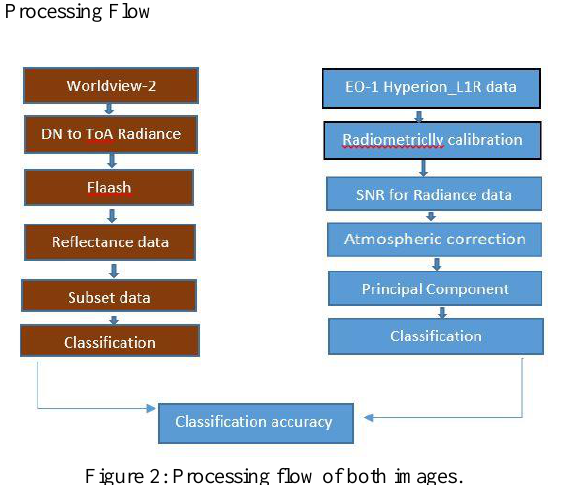
Figure 2: Processing flow of both